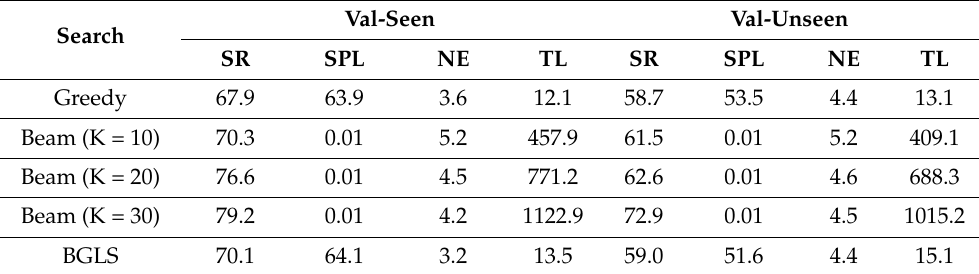
Table 4. Comparison among different search